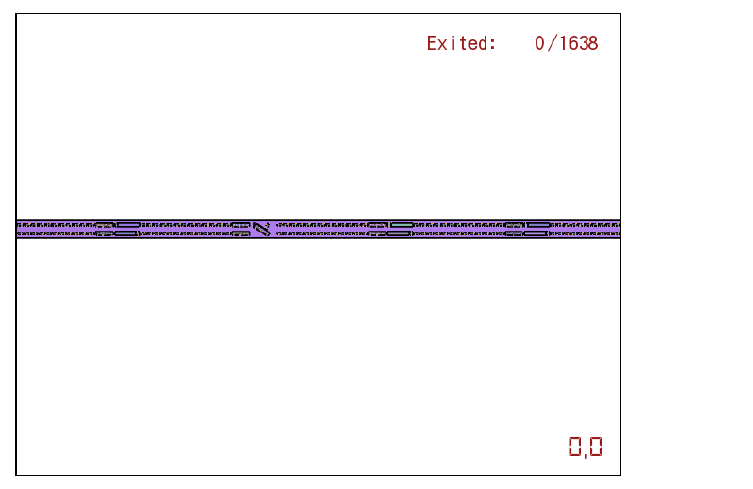
Figure 5 – The simulation example for the noted case with the noted location of crash at the start of the simulation